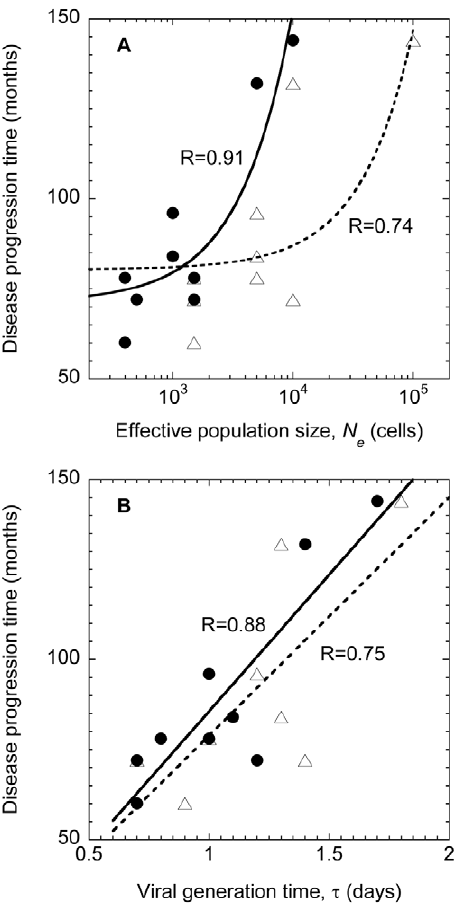
Figure 4. Correlations with disease progression. Correlation of (A) N e and (B) t with the disease progression time, or the time from seroconversion for the CD4 + T cell count to fall to 200 cells/ m L [36]. Symbols represent data obtained from our simulations with the frequency of multiple infections, M , =3 (circles) and drawn from a distribution based on a viral dynamics model (triangles) (see text). Linear fits (lines) to the data yield Pearson correlation coefficients of (A) 0.91 (circles) and 0.74 (triangles) and (B) 0.88 (circles) and 0.75 (triangles). Note that the x -axis in (A) is plotted on a logarithmic scale.